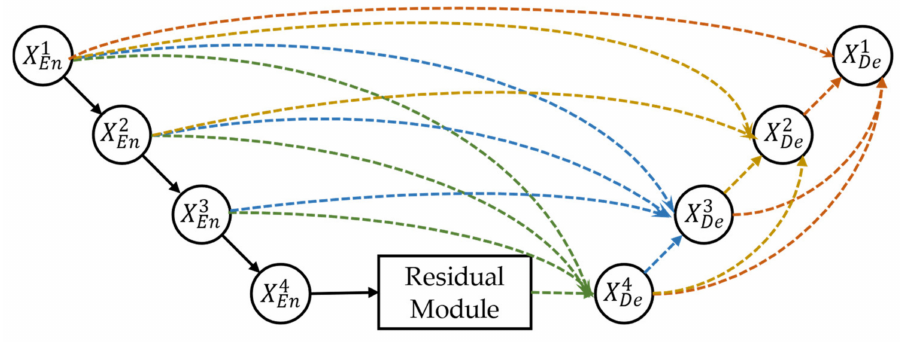
Figure 5. The proposed multi-scale skip connection based on the residual network, where X 1 X 3 , and X 4 are features of different scales in the encoding module, and X 1 En En are features of different scales in the decoding module. Features with the same number in superscript on the right indicate features of the same scale in the encoding and decoding